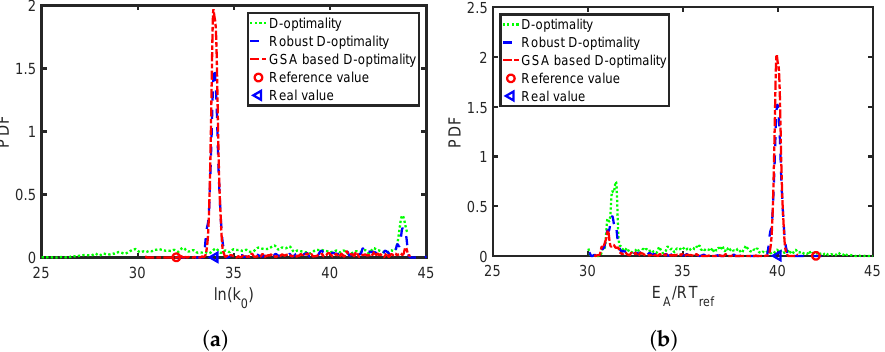
Figure 7. The resulting parameter distributions of the two Arrhenius parameters for the discussed MB-OED strategies. The red circle is the reference value used for MB-OED while the blue triangle is the true parameter value. ( a ) Arrhenius parameter k 0 ; ( b ) Arrhenius parameter E A .